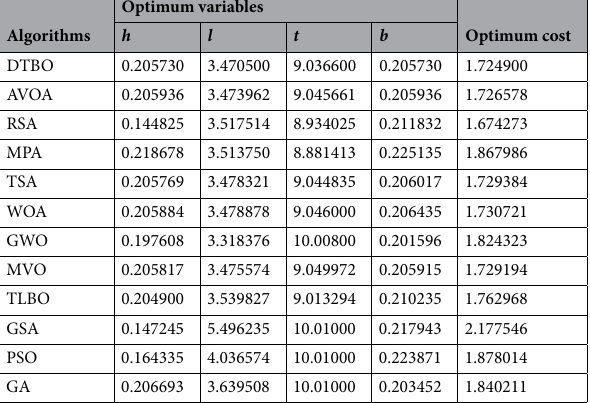
Table 10. Performance of optimization algorithms in the design of welded beams.